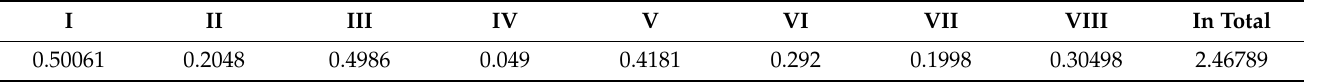
Table 9. The total potential of the observed telecom (according to the CTE